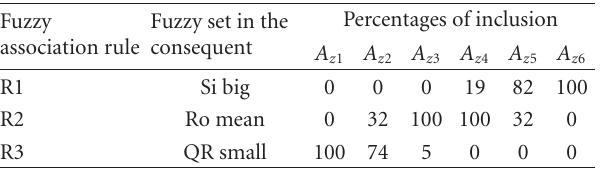
Table 9: Percentages of inclusion obtained for the fuzzy association